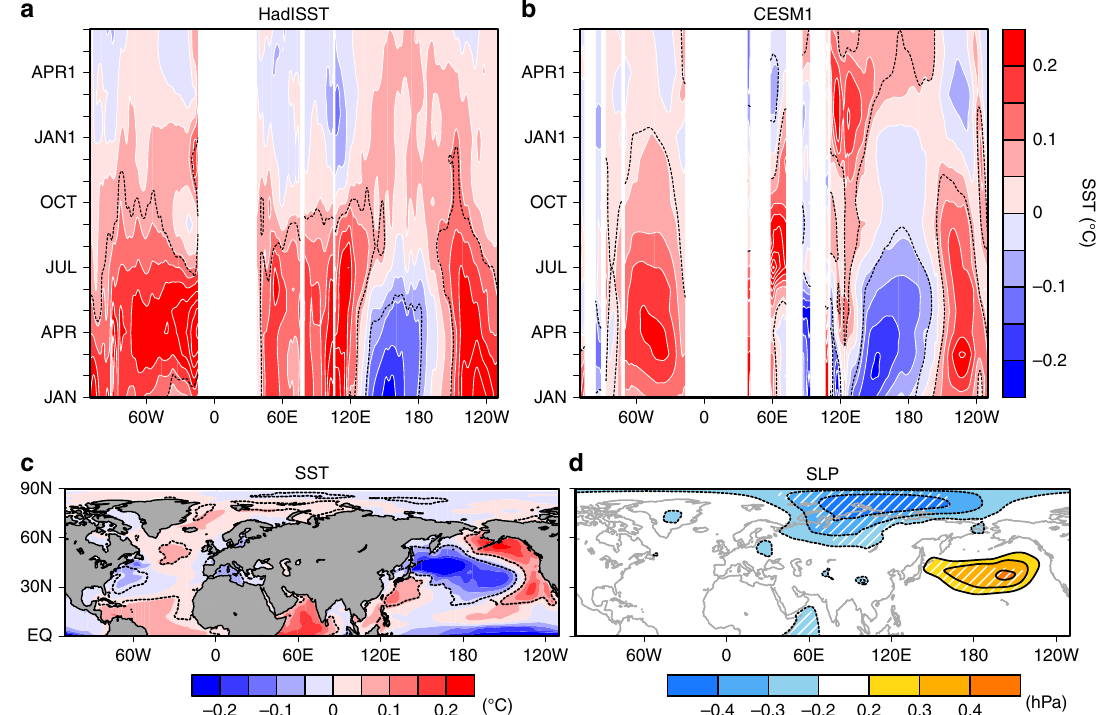
Fig. 3 Simulated surface climate anomalies in El Niño-decay year. Longitude – time section of sea surface temperature (SST) anomalies over 10° – 20°N regressed onto ENSO( – 1) in a HadISST (1958 – 2015) and b CESM1 ensemble mean (1958 – 2013). The time evolution is from January of ENSO-decaying year through June of the subsequent year. Regressed anomalies of c SST and d sea level pressure (SLP) in early winter onto ENSO( – 1) for CESM1 ensemble mean. Black dotted contours and hatching in d indicate statistical signi fi cance at the p < 0.05